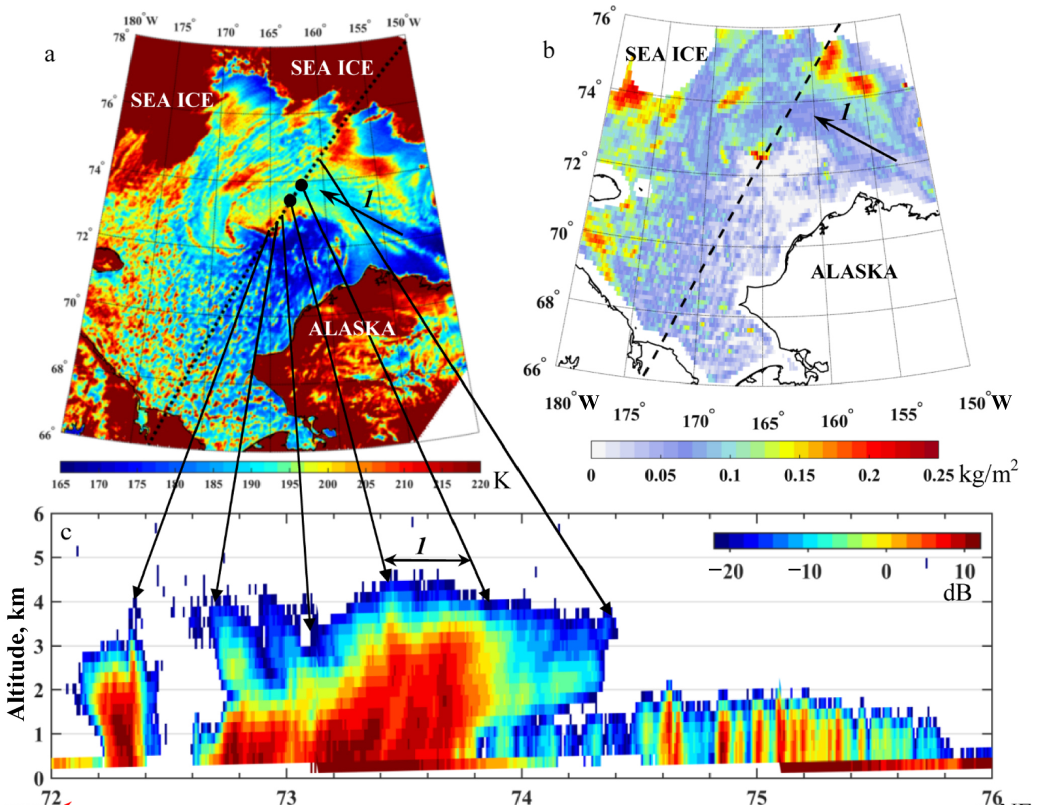
Figure 6. The brightness − 175 temperature fields at the 89 GHz frequency in horizontal polarisation ( a ) and the total cloud liquid water content ( b ) from the AMSR2 measurements at 14:25 UTC, and vertical cross-section of the clouds close to the PL 3 center from the CPR measurements at 14:34 UTC ( c ) on 19 October 2017. The arrows on ( a ) indicate segments of the cross-section on ( c